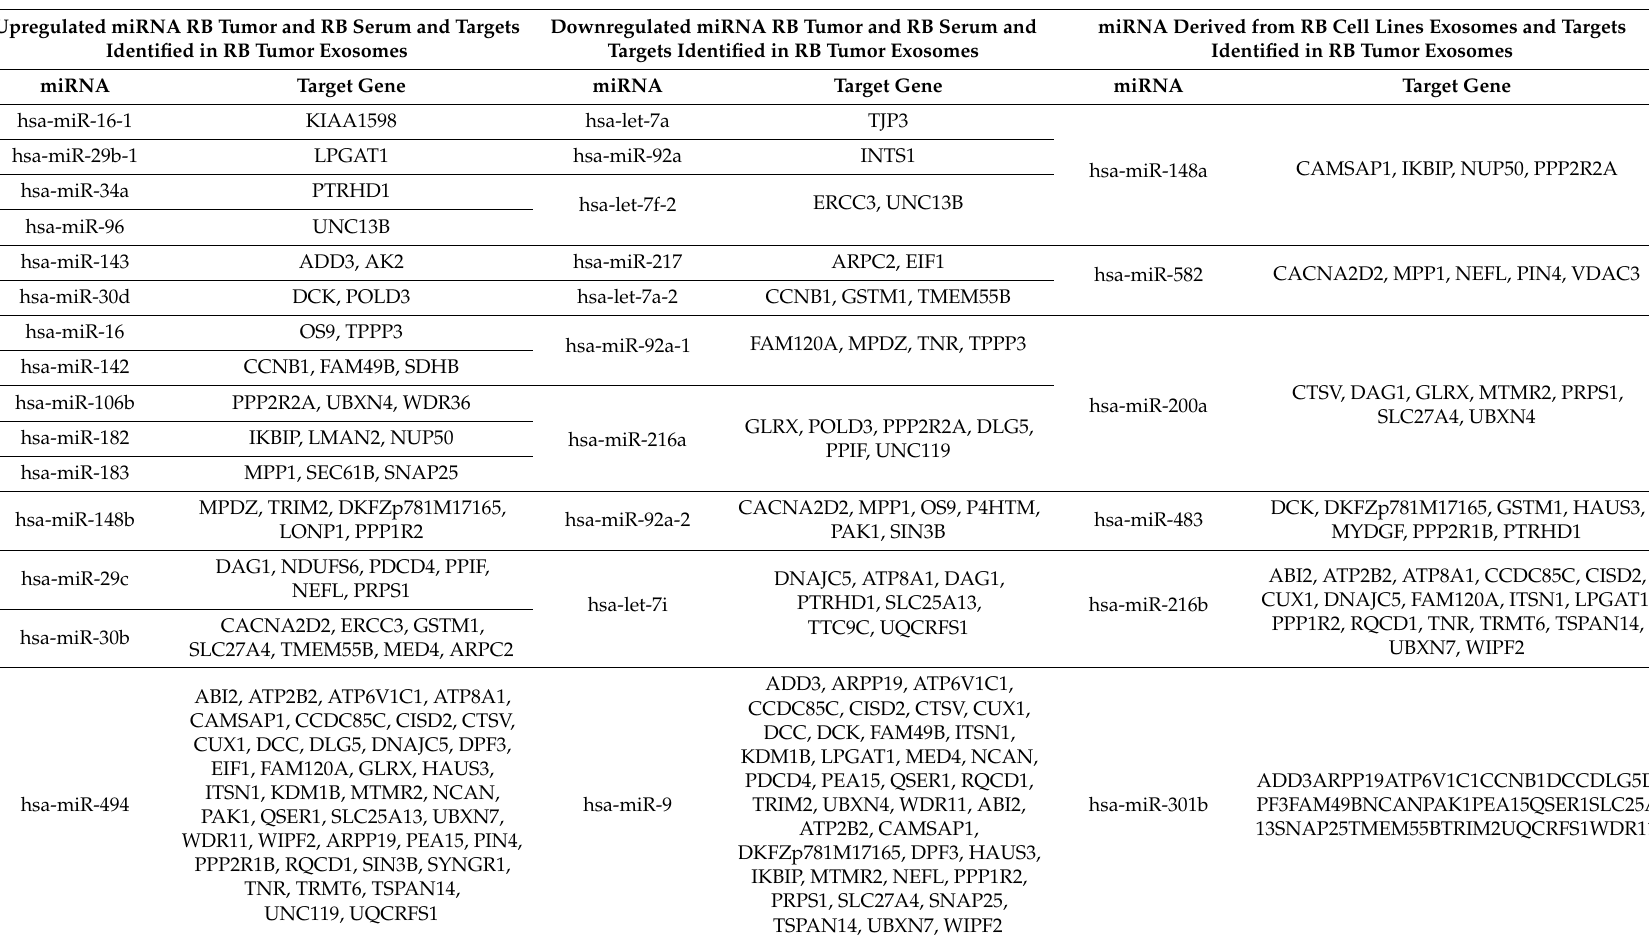
Table 1. The list of miRNA reported in RB tumor, RB serum, and RB cell lines and their targets from the proteins identified in the RB tumor exosomes. Upregulated miRNA RB Tumor and RB Serum and Targets Downregulated miRNA RB Tumor and RB Serum and miRNA Derived from RB Cell Lines Exosomes and Targets Identified in RB Tumor Exosomes Targets Identified in RB Tumor Exosomes Identified in RB Tumor